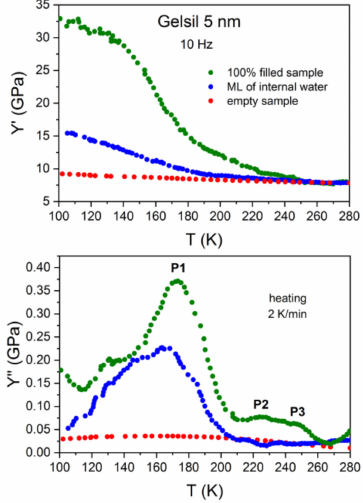
Figure 2. Temperature dependencies of real (Y’, top panel) and imaginary (Y”, lower panel) parts of the complex Young´s modulus of water in Gelsil 5 nm, measured at heating (heating rate 2 K / min) after the sample was slowly (2 K / min) cooled to 80 K. The results of the samples fully filled with water (green), partly filled (blue) and empty samples (red) are